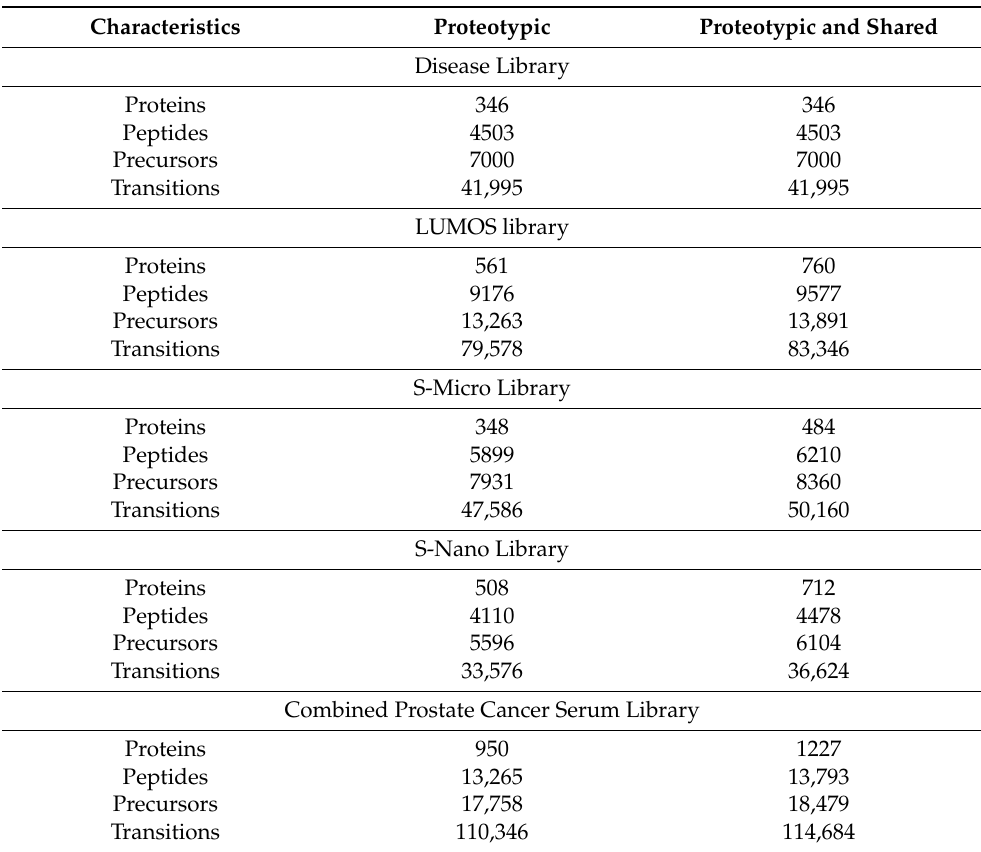
Table 1. Details of the in silico (Disease), in-house built PCa spectral libraries acquired at Orbitrap Fusion Lumos Tribrid (Thermo Scientific, Waltham, MA, USA) mass spectrometer (in micro-flow mode) (Lumos), Sciex TripleTOF 6600 mass spectrometer in micro-flow mode (S-Micro) and nano- flow mode (S-Nano) and combined library (Combined-PCa) built after the integration all four,